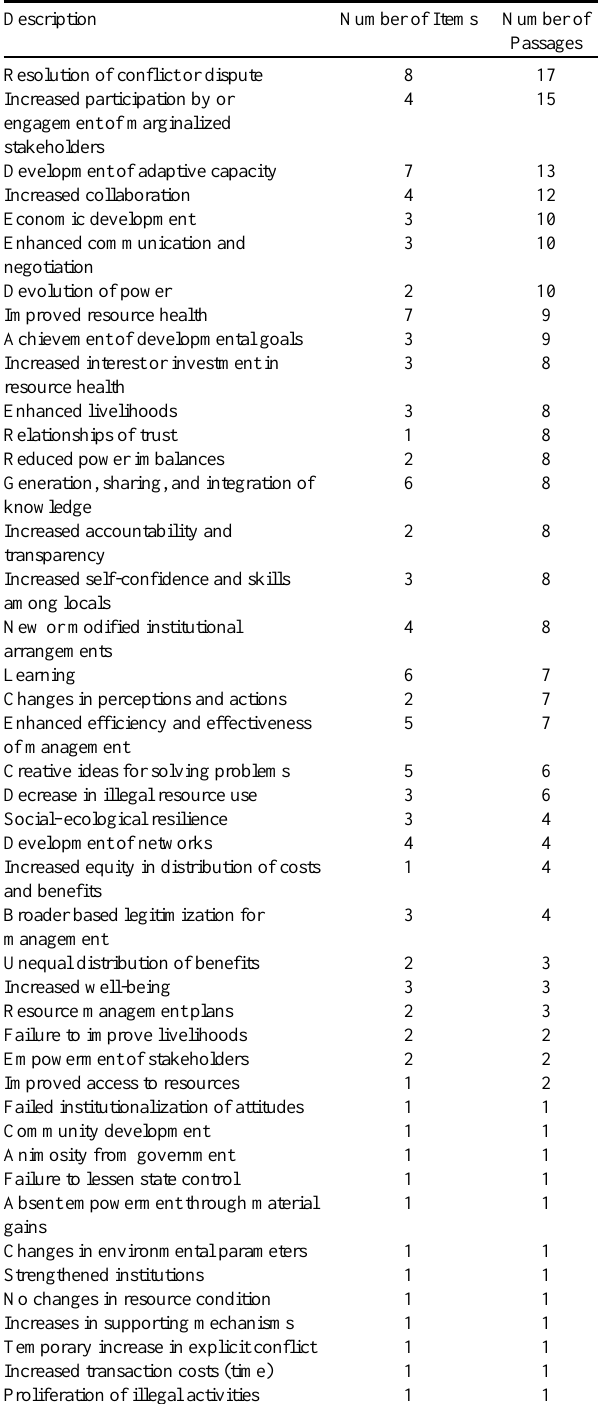
Table 3. Actual outcomes of adaptive